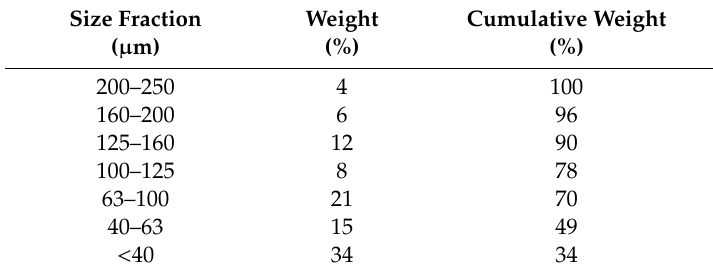
Table 2. Particle size distribution of the road-deposited sediments used within this